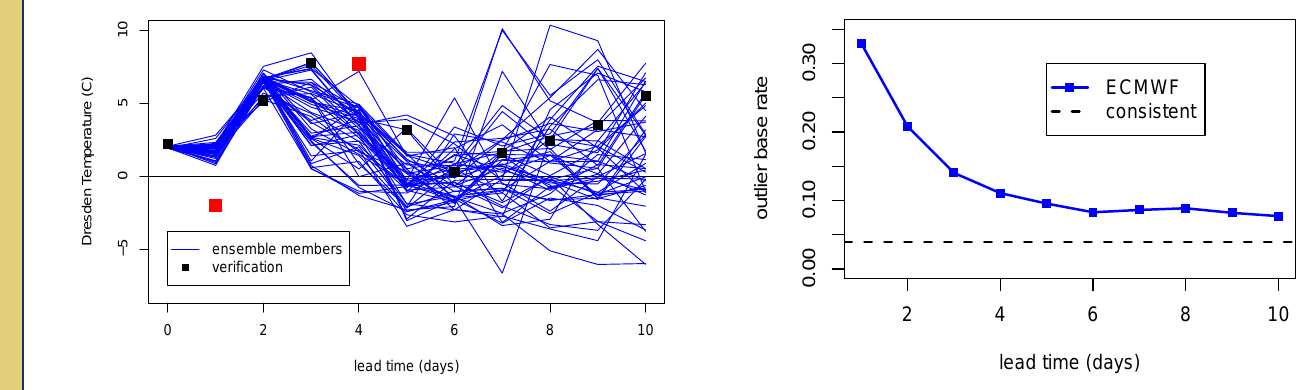
Figure 1. An ensemble temperature forecast issued by the ECMWF. Initialization date (lead time 0) is 22 December 2004, the location is WMO10488 (Dresden, Germany). The outliers at lead times 1 and 4 days are marked red.